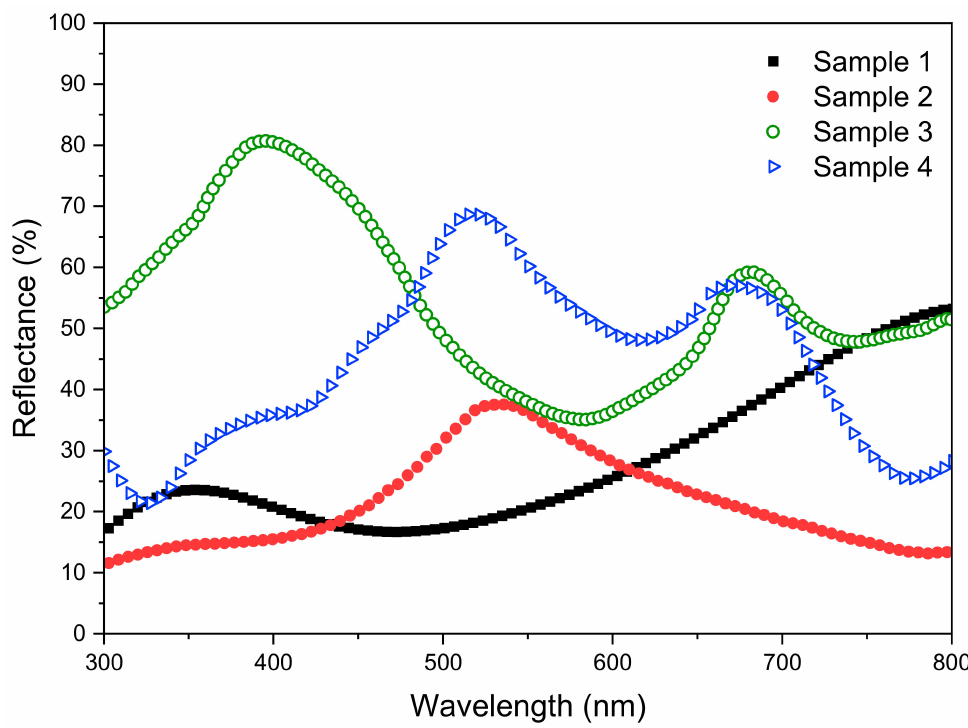
Figure 2. Optical reflectance of laser-processed steel